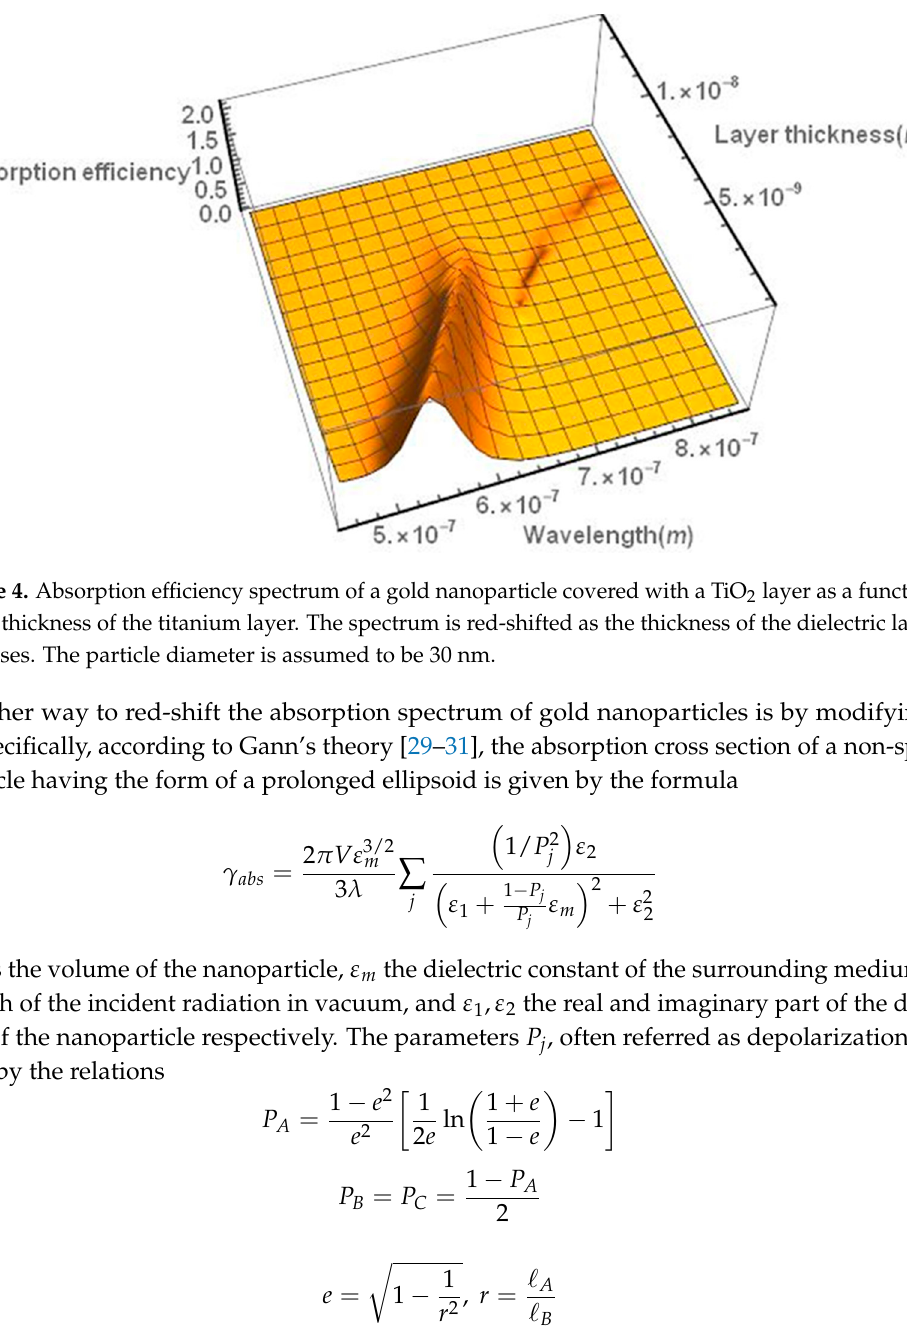
Figure 3. Absorption efficiency spectrum of a gold nanoshell as a function of the thickness of the gold layer. The spectrum is red-shifted as the nanoshell thickness decreases. The particle diameter is assumed to be 30 nm, as in the case of the hyperthermia simulations.